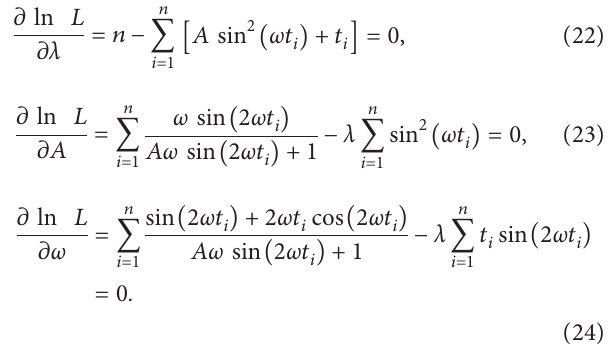
Figure 18: Effects of oscillation angular frequency on failure rate.